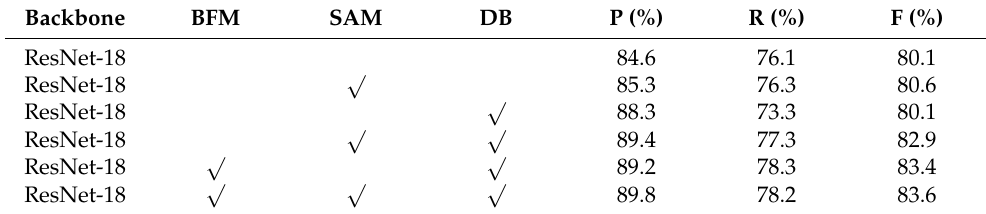
Table 1. Results of the ablation experiments on the ICDAR2015